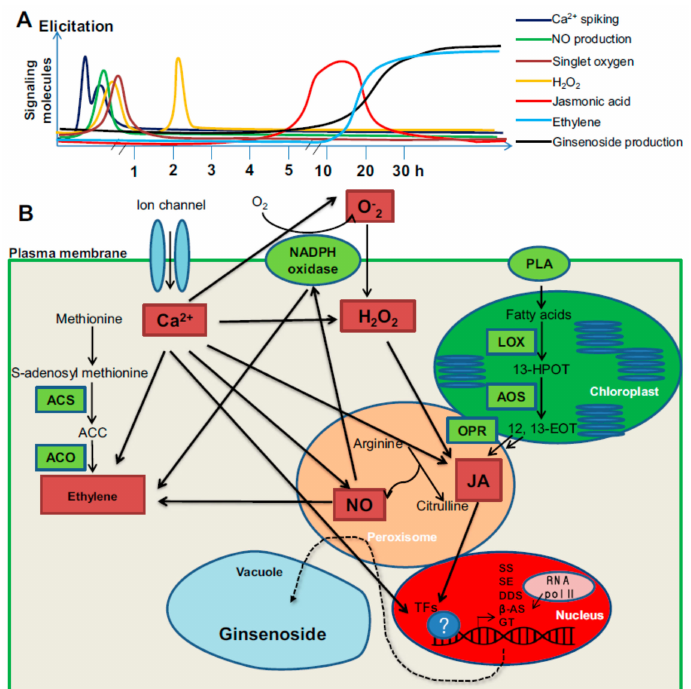
Figure 5. Schematic illustration of the sequential signalling pathways activated in elicited ginseng ( A ). Model of cross-talk between different signal transductions ( B ). Cross talk between different signalling molecules is shown by bold arrows. ACC 1-aminocyclopropane-1-carboxylic acid, ACS 1-aminocyclopropane-1-carboxylic acid synthase, ACO 1-aminocyclopropane-1-carboxylic acid, AOS allene oxide synthase, β -AS beta-amyrin synthase, DDS dammarenediol synthase, 12,13-EOT 12,13(S)-epoxyoctadecatrienoic acid, H 2 O 2 hydrogen peroxide, 13-HPOT (13S)-hydroperoxyoctadecatrienoic acid, JA jasmonic acid, LOX lipoxygenase, NO nitric oxide, NOS nitric oxide synthase, O 2 − superoxide radical, OPR oxophytodienoate reductase, PLA phospholipase, SS squalene synthase, SE squalene epoxidase, TFs transcription factors, UGRdGT UDPG / ginsenoside Rd glucosyltransferase (Adapted from Rahimi et al.